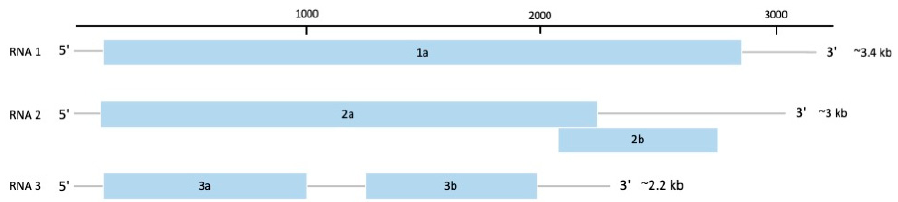
Figure 6. Schematic representation of the genome of species Cucumber mosaic virus (CMV), genus Cucumovirus , family Bromoviridae . The proteins encoded by each RNA are 1a: replication protein, 2a: RNA-dependent RNA polymerase, 2b: silencing suppressor, 3a: movement protein, and 3b: capsid protein.